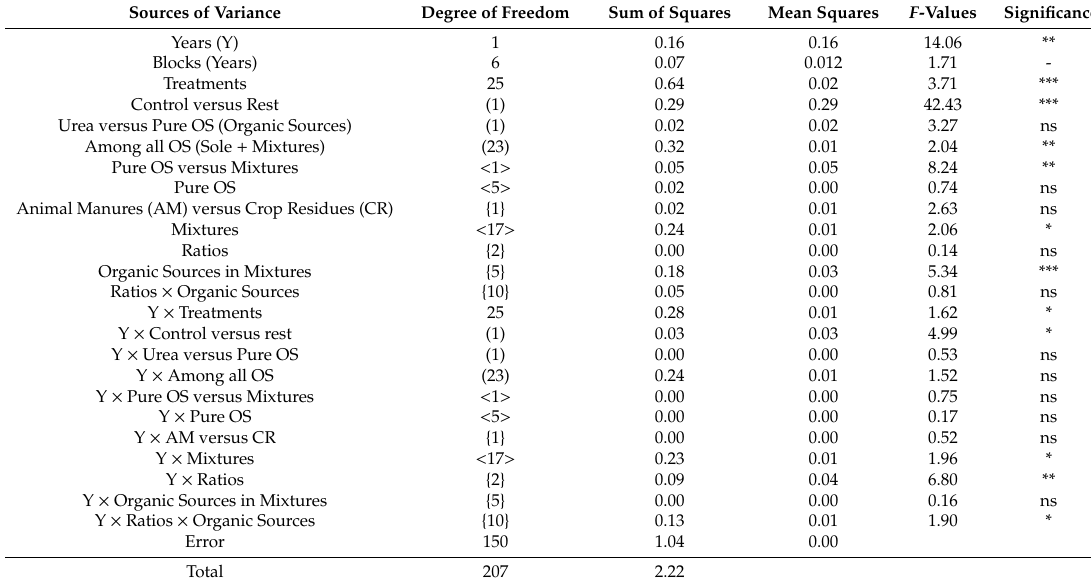
Table 5. Analysis of variance for nitrogen concentration in straw (%) of rice hybrid “Pukhraj” as a ff ected by organic and inorganic